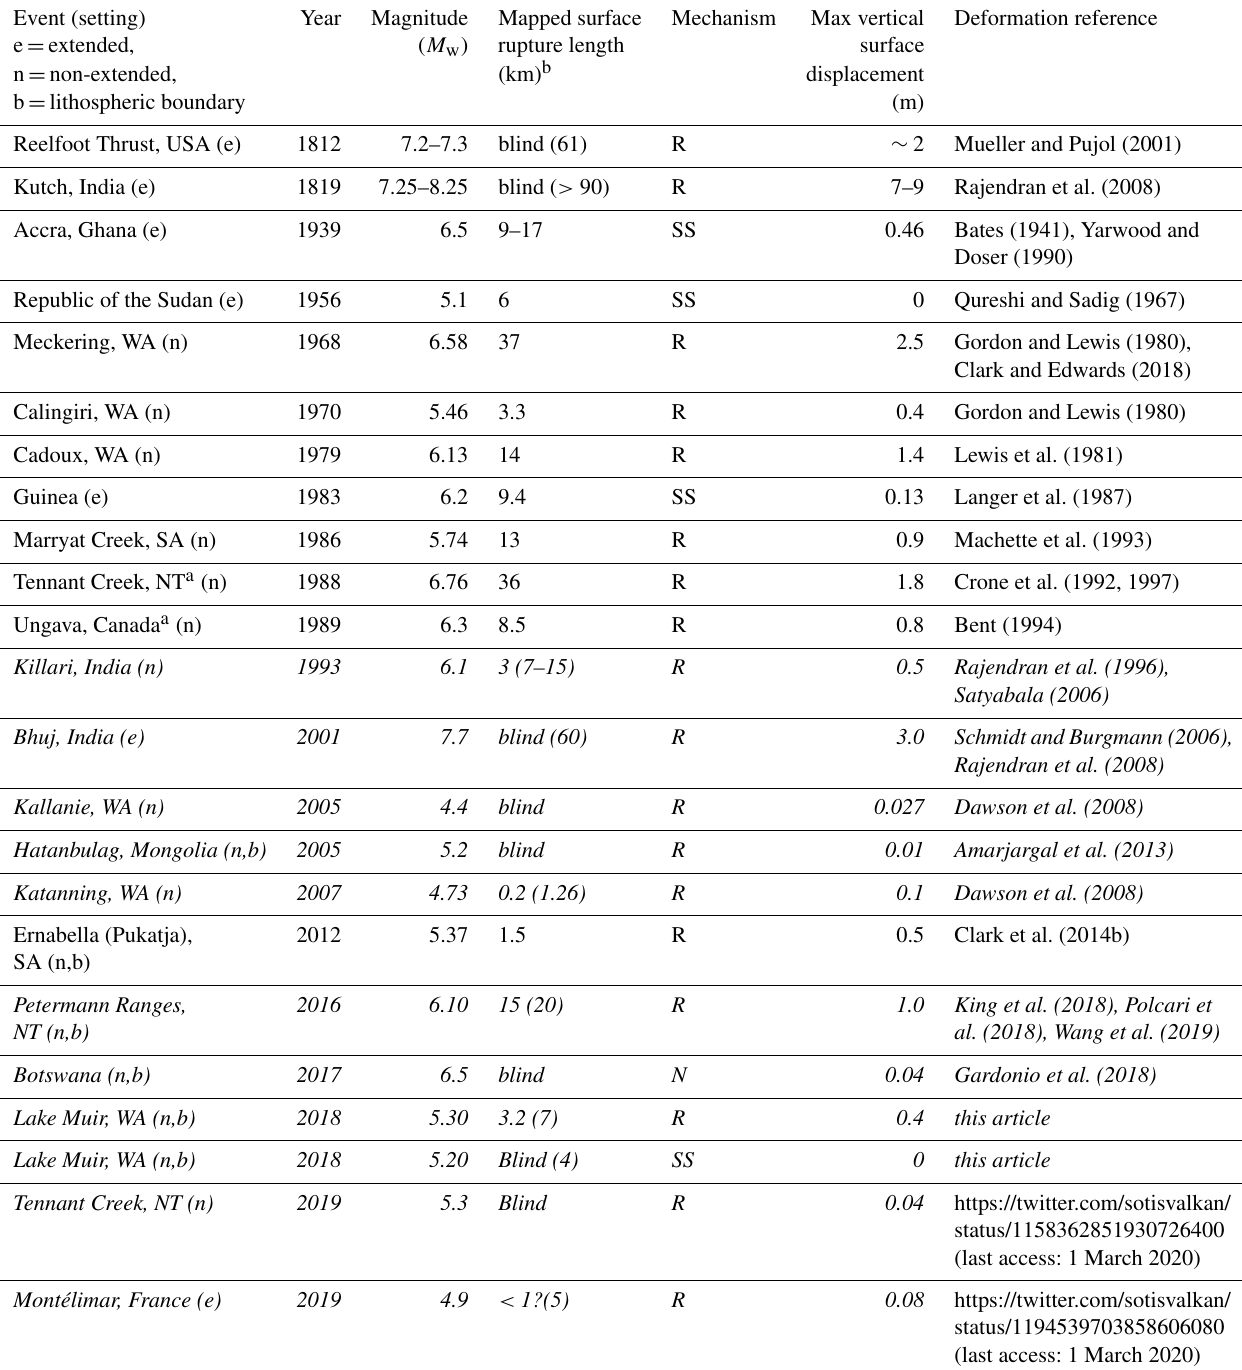
Table 1. Historical earthquake events known to have produced surface rupture in stable continental region crust (expanded after Crone et al., 1997; Clark et al., 2014b). Cells in italic font are events for which an InSAR image was produced. NT: Northern Territory; SA: South Australia; and WA: Western